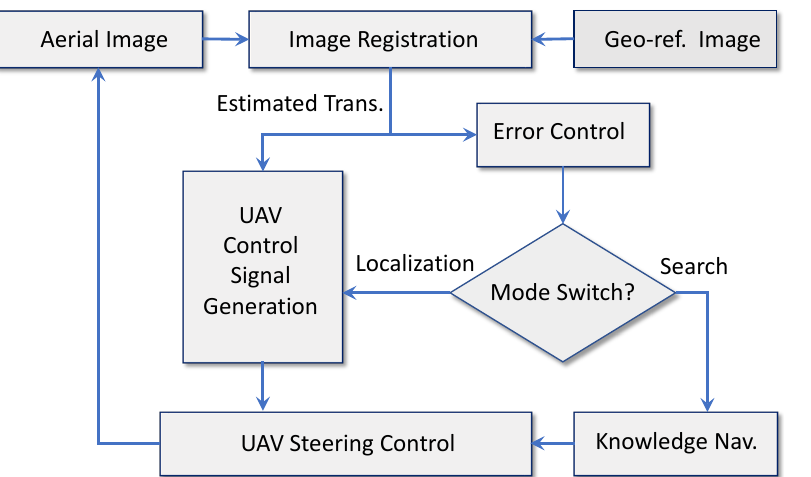
Figure 1. Illustration of the unmanned aerial vehicle (UAV) self-localization process using landmark